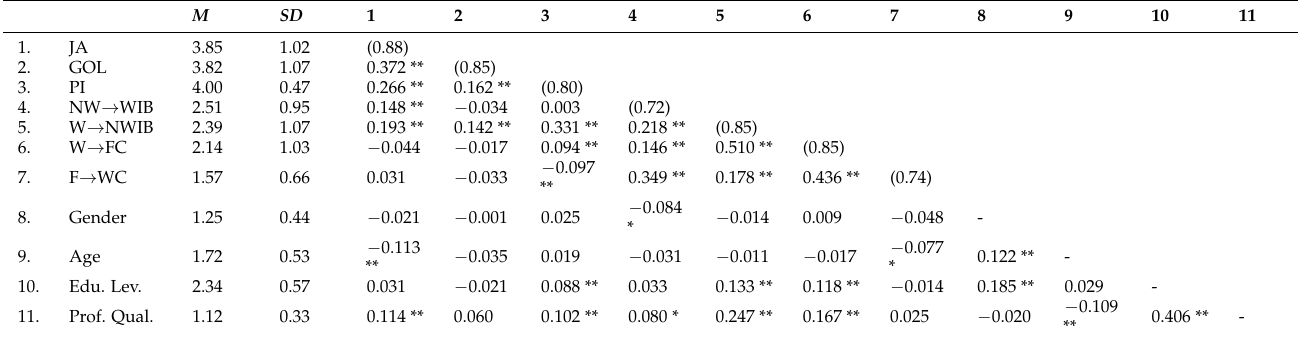
Table 1. Descriptive statistics and zero-order correlations.